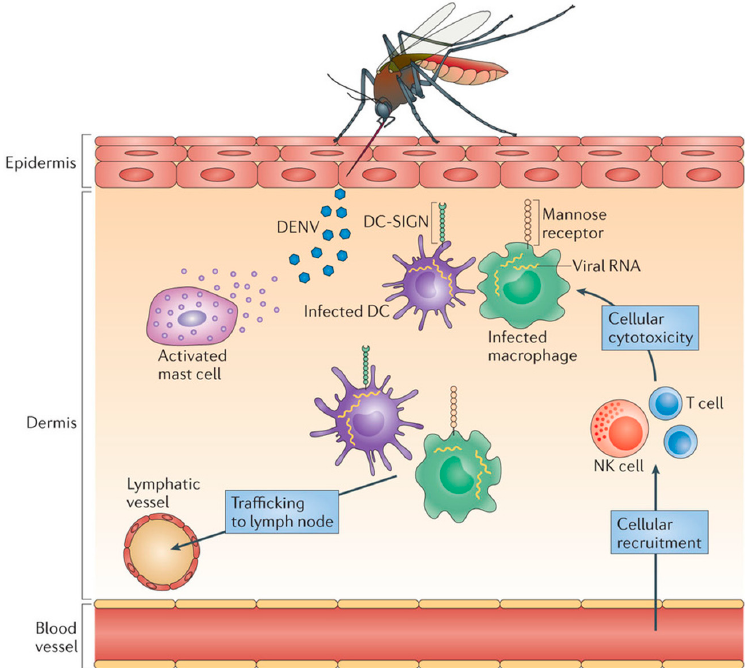
Figure 2. Dengue pathogenesis. Released viral particles may infect adjacent cells (mostly monocytes